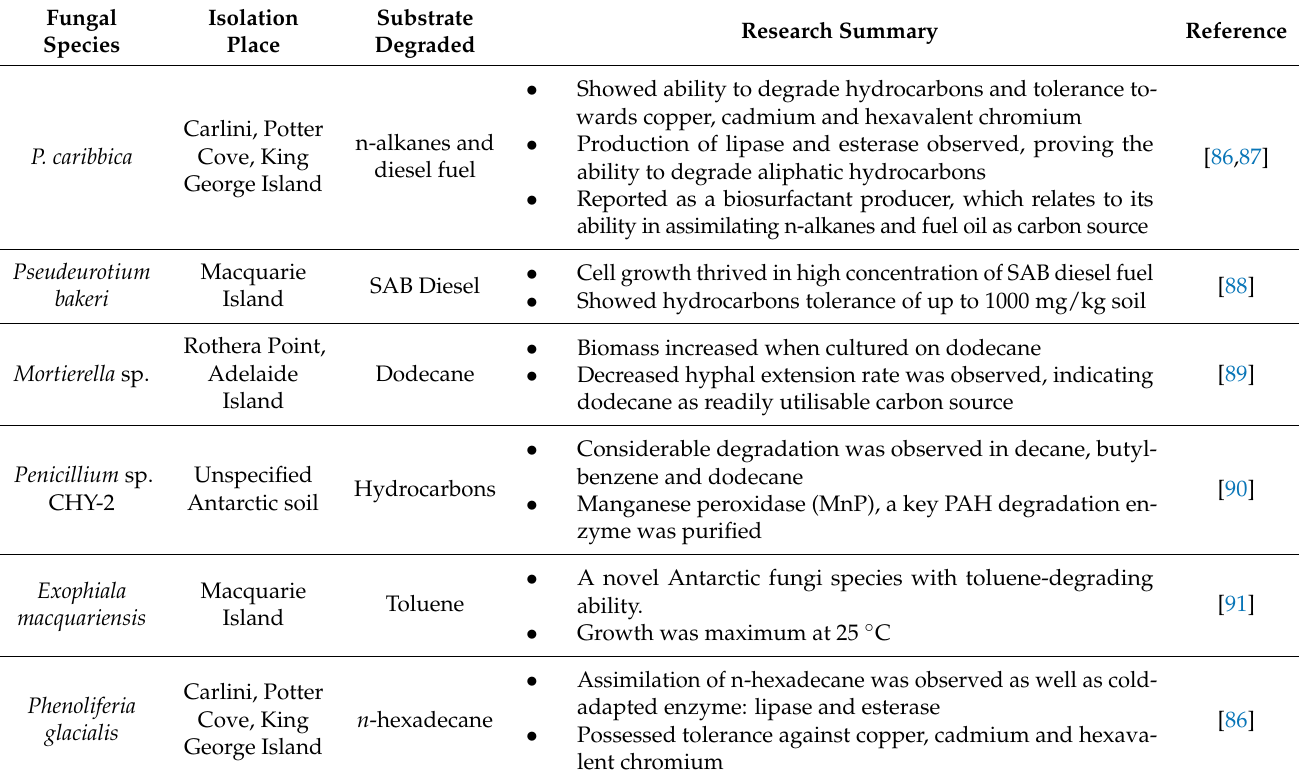
Table 4. Hydrocarbon-degrading fungal species isolated from